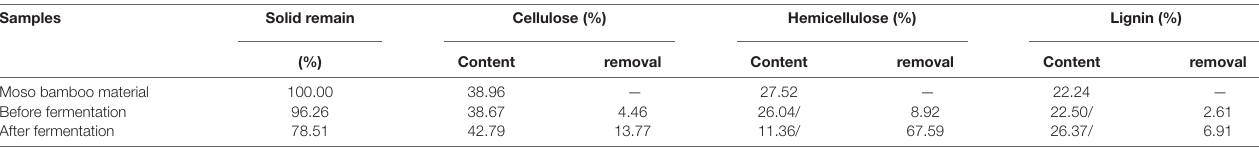
TABLE 1 | Chemical composition change before and after fermentation. Samples